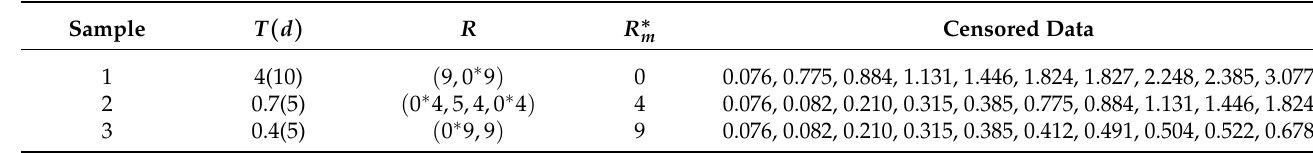
Table 2. Different generated samples from SSB data set.